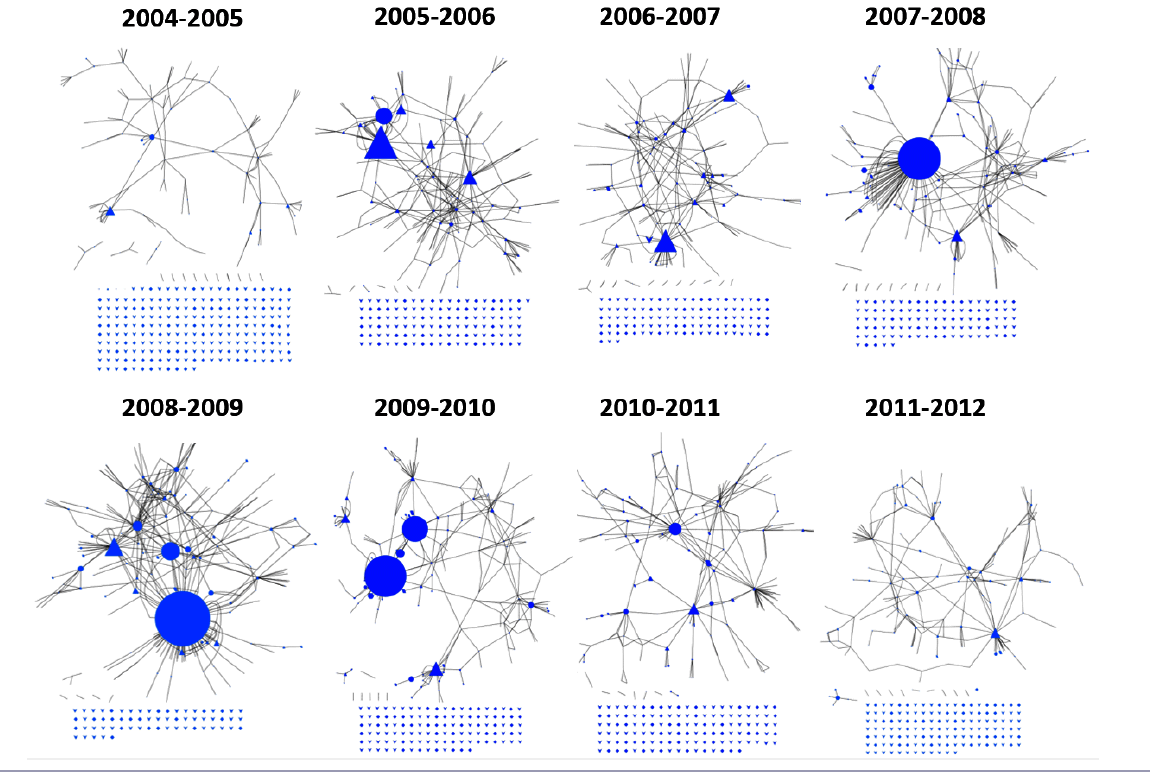
Fig. 4 . Network maps depicting the annual evolution of coral trout (CT) lease-trade relationships, 2004-2005 to 2011-2012. Circles denote quota redistributors that land more than one tonne of fish (> 1 t), triangles indicate quota redistributors that land less than one tonne of fish (< 1